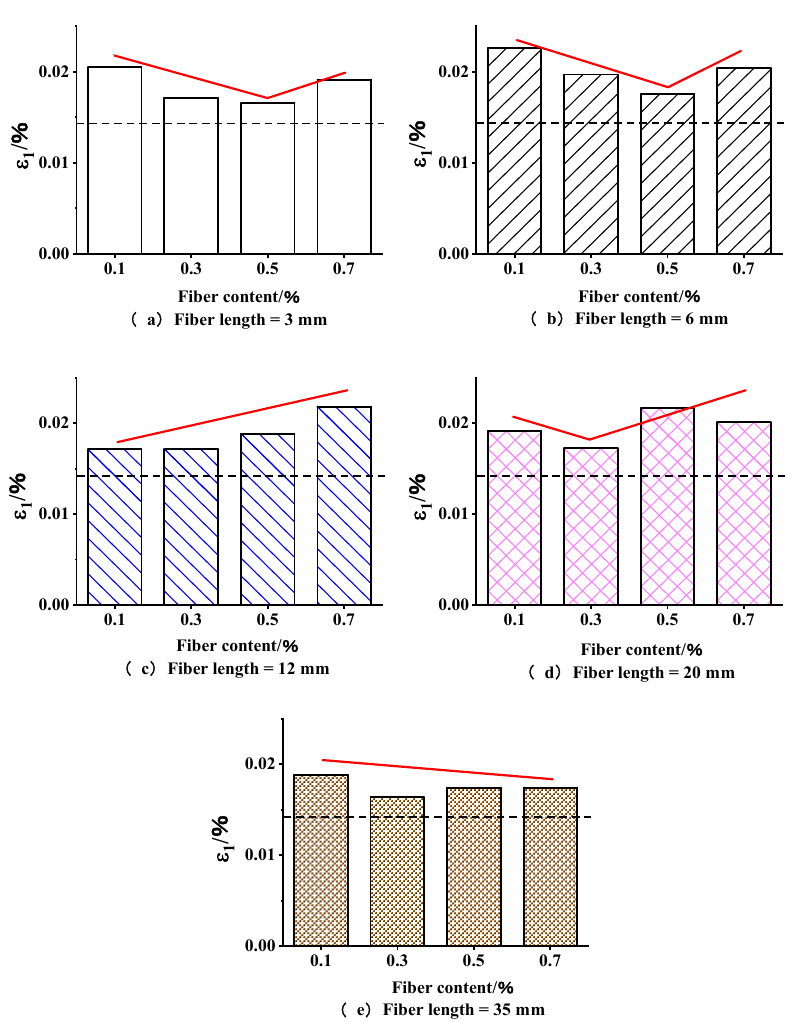
Figure 8. Variations in the damage strain with fiber content and different fiber lengths.